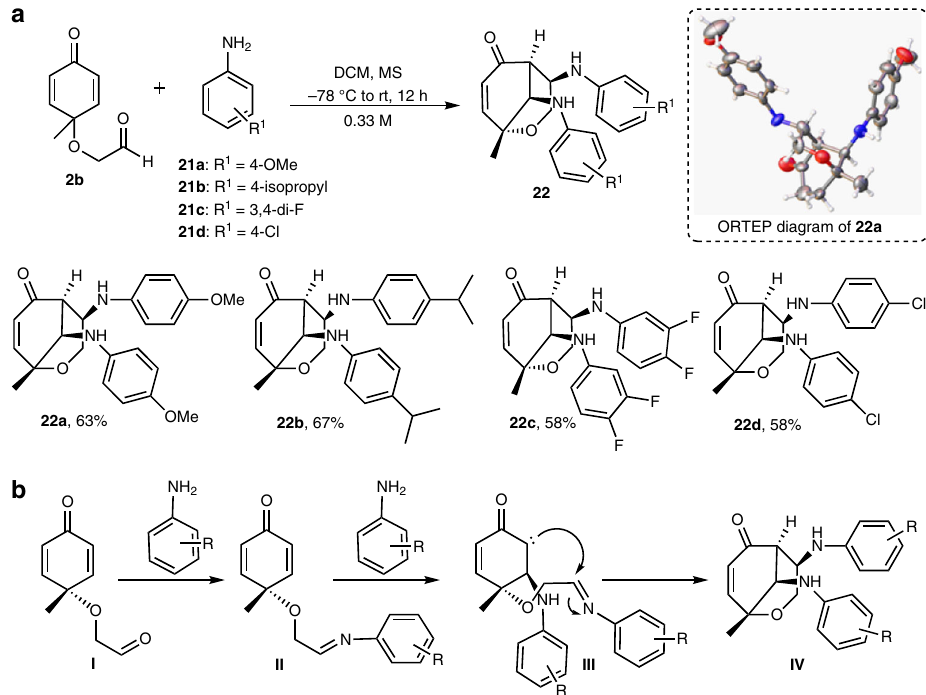
Fig. 7 Tandem synthesis of oxocanes employing aniline and quinone derivatives. a Diatereoselective synthesis of oxocanes. b A proposed mechanism for the formation of oxocanes. MS molecular